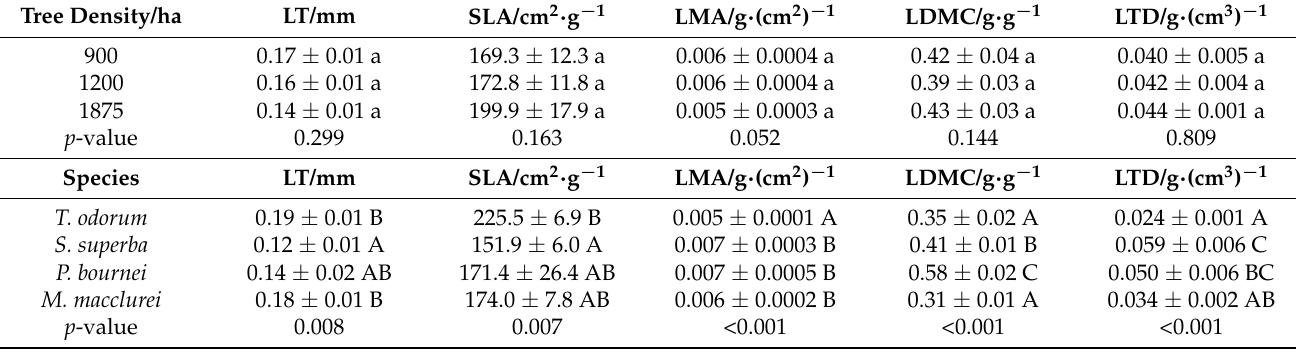
Table 3. Leaf functional traits of four broad-leaved trees species underplanted in Chinese fir plan- tations with different tree density (Mean ± SE). Means followed by different lower case letters are different among tree density levels and those followed by upper case letters are significantly different among